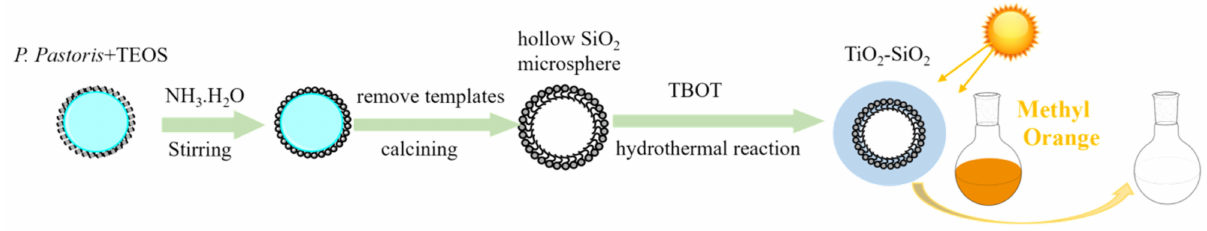
Figure A1. Reaction mechanism